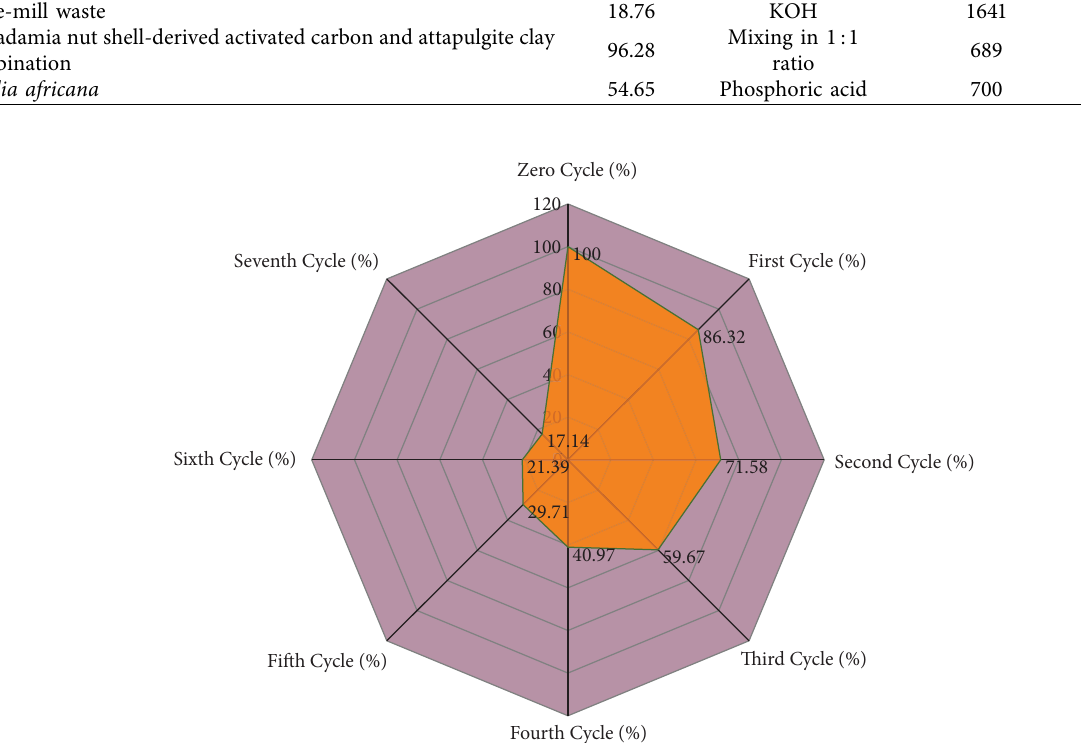
Figure 7: Regeneration